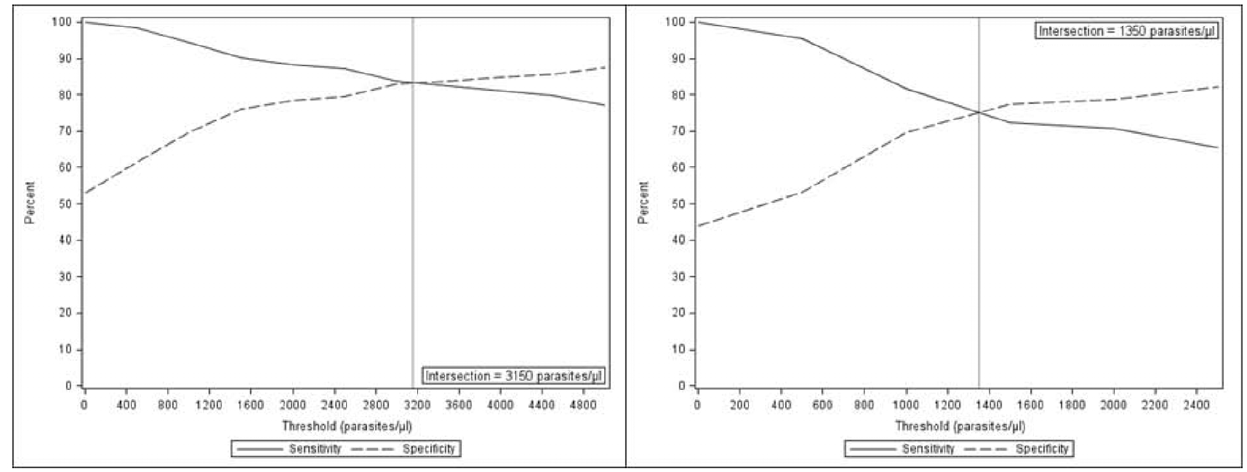
Figure4.Malariacasedefinitionusingobjectiveandsubjectivefeveraccordingtotheseason. a.Sensitivityandspecificityofalternativeparasite threshold for malaria case definition in the high transmission season using objective ( . =37.5 degrees C) and subjective fever. b. Sensitivity and specificity of alternative parasite threshold for malaria case definition in the low transmission season using objective ( . =37.5 degrees C) and subjective fever.